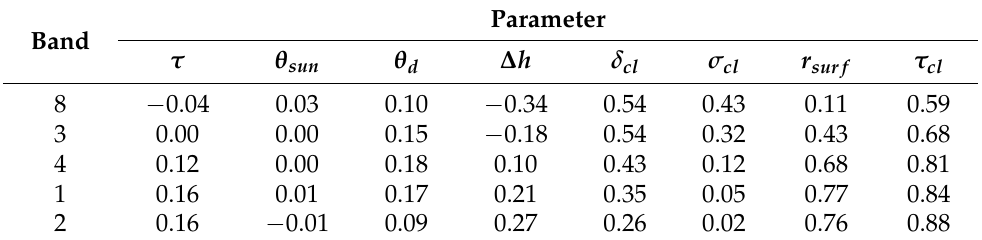
Table 5. Coefficients of correlation of the initial parameters with the CAE radius.